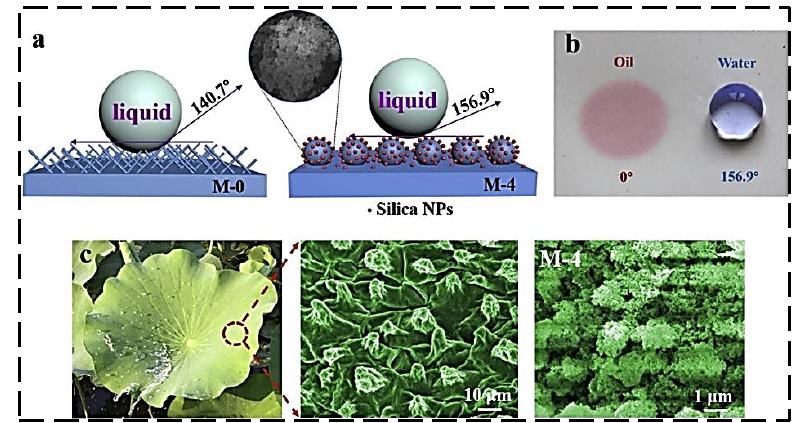
Figure 6. ( a ) Diagrams illustrate the effect of bottom surface structure of M-0 and M-4 on the hydrophobic; ( b ) Photograph of pure water and oil droplets on the M-4 bottom surface; ( c ) Optical photograph and SEM image of lotus leaf [119]. Reprinted with permission from Ref. [119]. Copyright 2019 Elsevier B.V. All rights reserved.